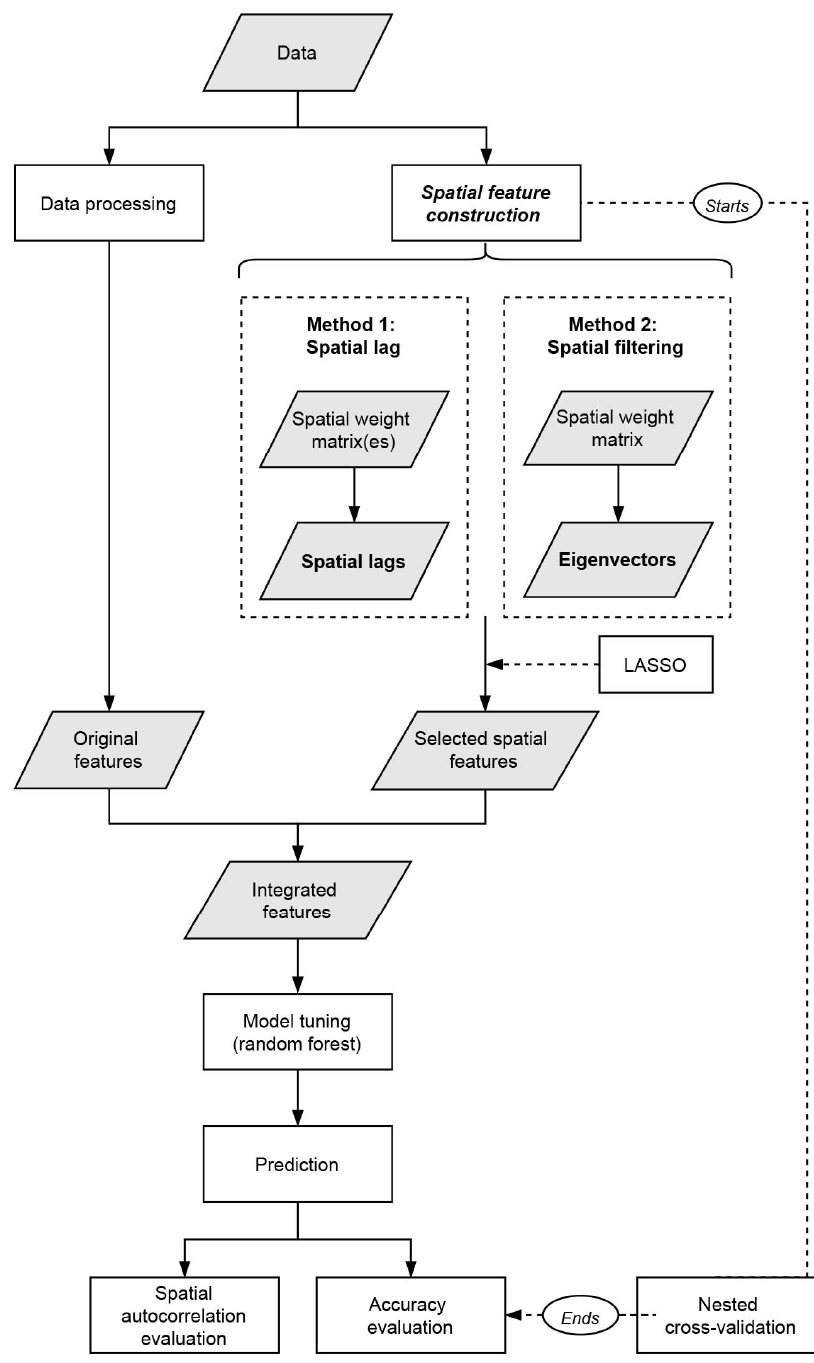
Figure 1. Procedures for the proposed spatial machine learning prediction workflow.